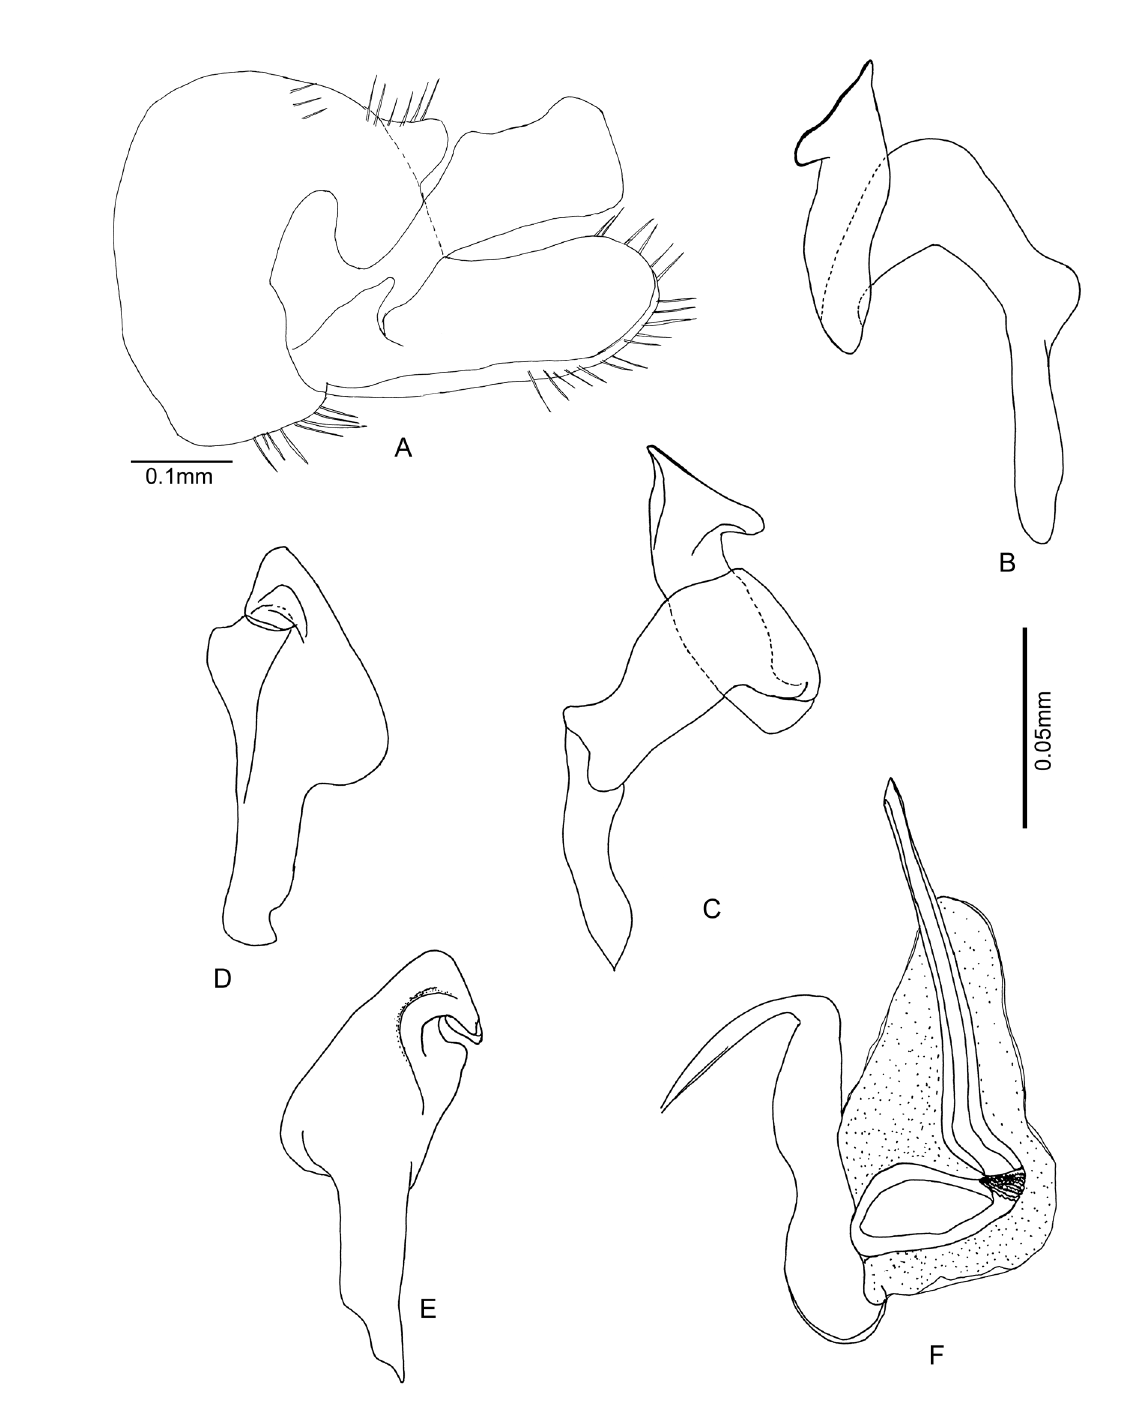
Fig. 16. Male genitalia of Harpedona vittlaensis sp. nov., holotype, UASB. A . Genital capsule in lateral view. B–C . Left paramere in dorsal and lateral views. D–E . Right paramere in dorsal and lateral views. F . Aedeagus in lateral